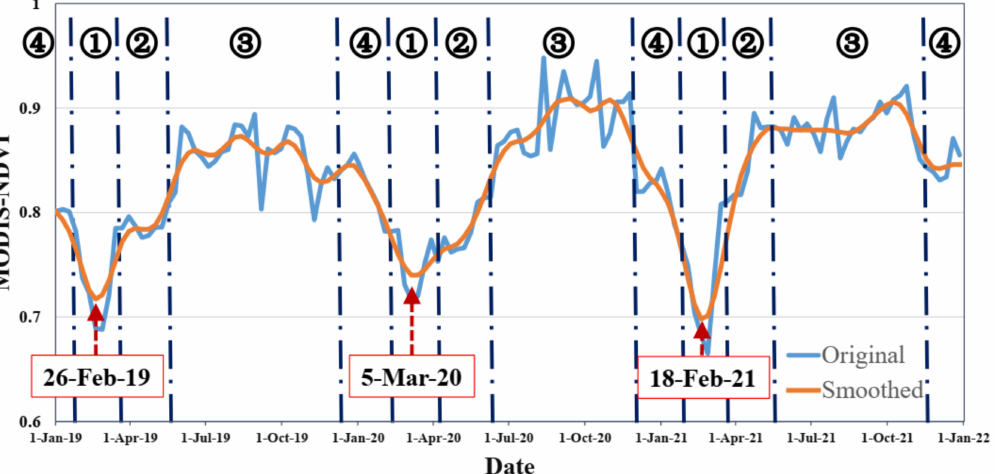
Figure 5. MODIS-NDVI variation curves for rubber plantations from 2019 to 2021. 1 (cid:13) : Resting stage, 2 (cid:13) : Recovery growth stage, 3 (cid:13) : Vigorous growth stage, 4 (cid:13) : Slowdown growth